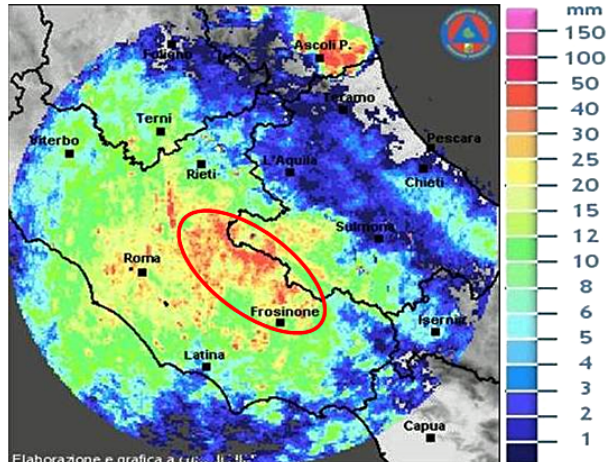
Figure 9. 12h accumulated rainfall between 10:00 and 22:00UTC on 20 May 2008 estimated by the Monte Midia